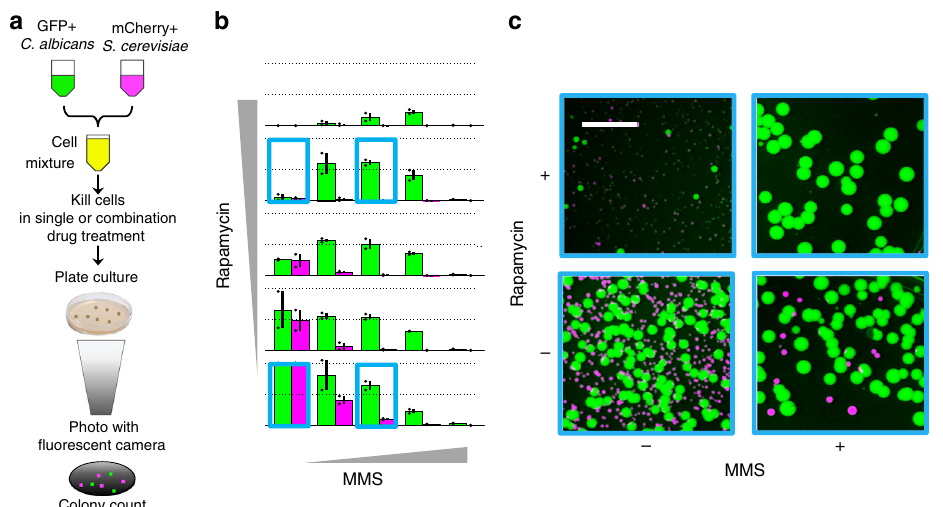
Fig. 5 Multiplexed fungicidal drug-interaction assay illustrates selectivity increase via antagonism. a mCherry expressing S. cerevisiae and GFP expressing C. albicans cells were co-cultured in 2D grids of drug combinations in liquid media and transferred to YPD-agar plates. After 48-hour incubation, plates were photographed and cells enumerated with ImageJ software. b Bar charts of size proportional to cell number compared to the no drug control and color representative of species (green: C. albicans , magenta: S. cerevisiae ) are shown for each MMS-rapamycin combination tested. For each subplot, the top dashed line represents CFUs equal to those observed for the no drug control and the second dashed line represents half the CFUs relative to those observed for the control. Error bars represent ± S.E.M. of two independent experiment results, overlaid on the bar charts as dots ( n = 2). The experiments indicated with boxes correspond to four representative images of colonies post-incubation in variable drug conditions shown in c . c While rapamycin and MMS are both toxic for these two yeast species, a low MMS-high rapamycin combination selects for the survival of C. albicans . The gray line is 15 mm, all images are of the same